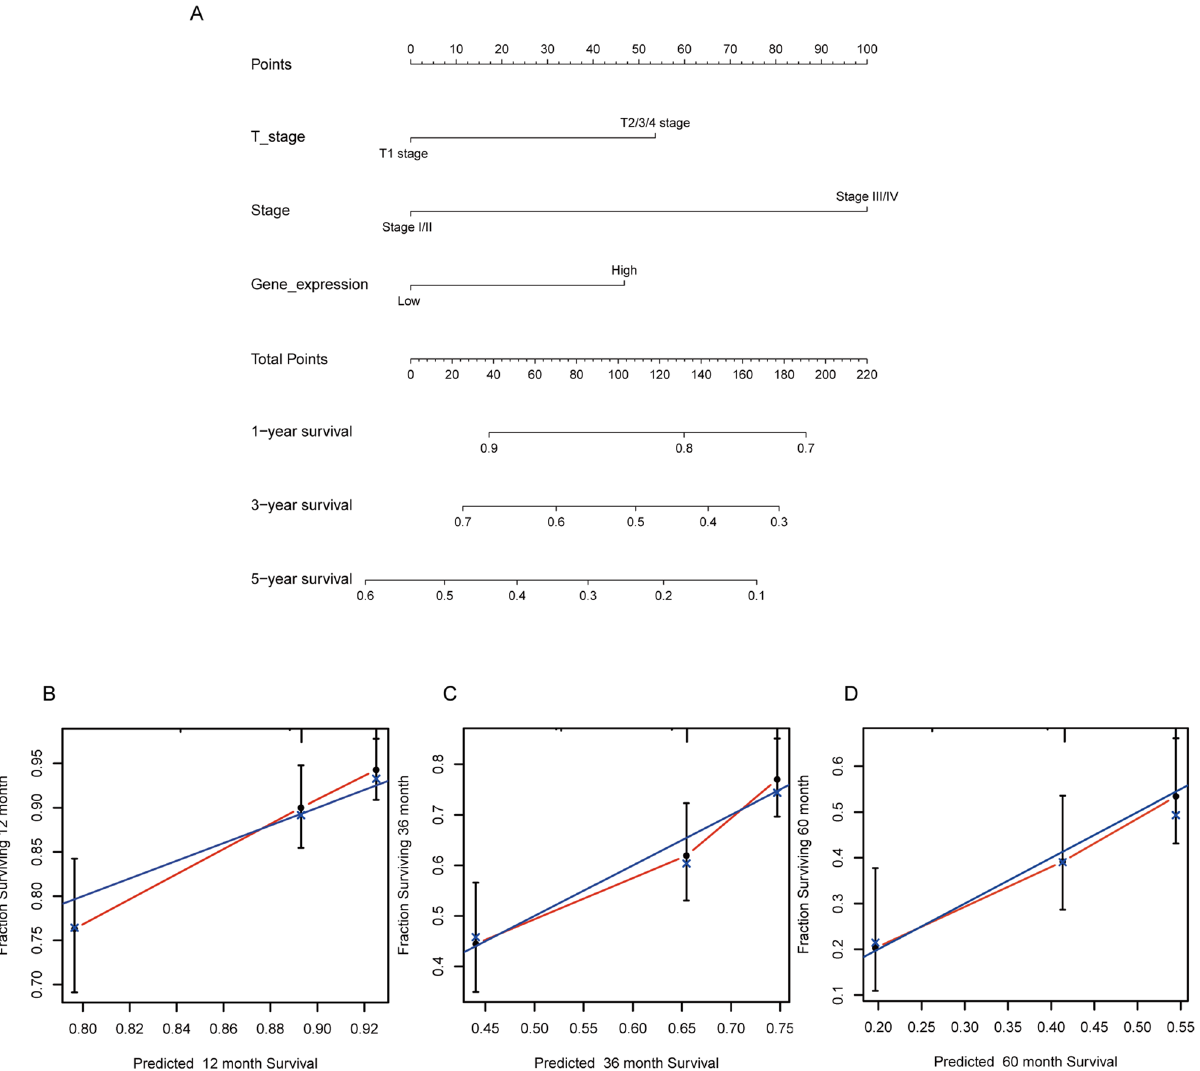
Figure 3. Nomogram and calibration curve for predicting the probability of 1-, 3- and 5-year OS for LUAD patients. ( A ) A nomogram integrates GREB1L and other prognostic factors in LUAD from TCGA data; ( B – D ) The calibration curve of the